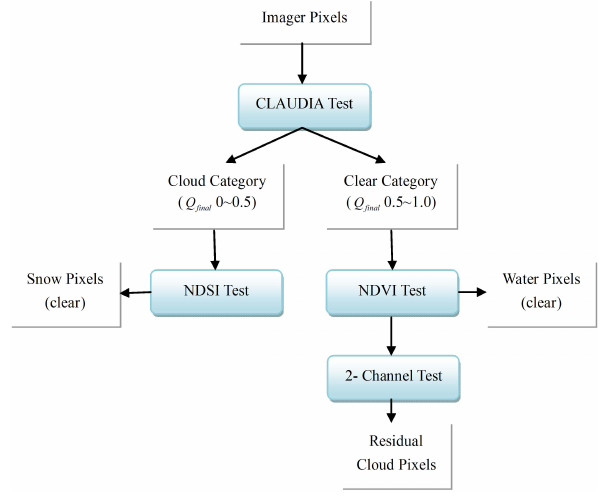
Fig. 5. The flow chart of the improved cloud detection